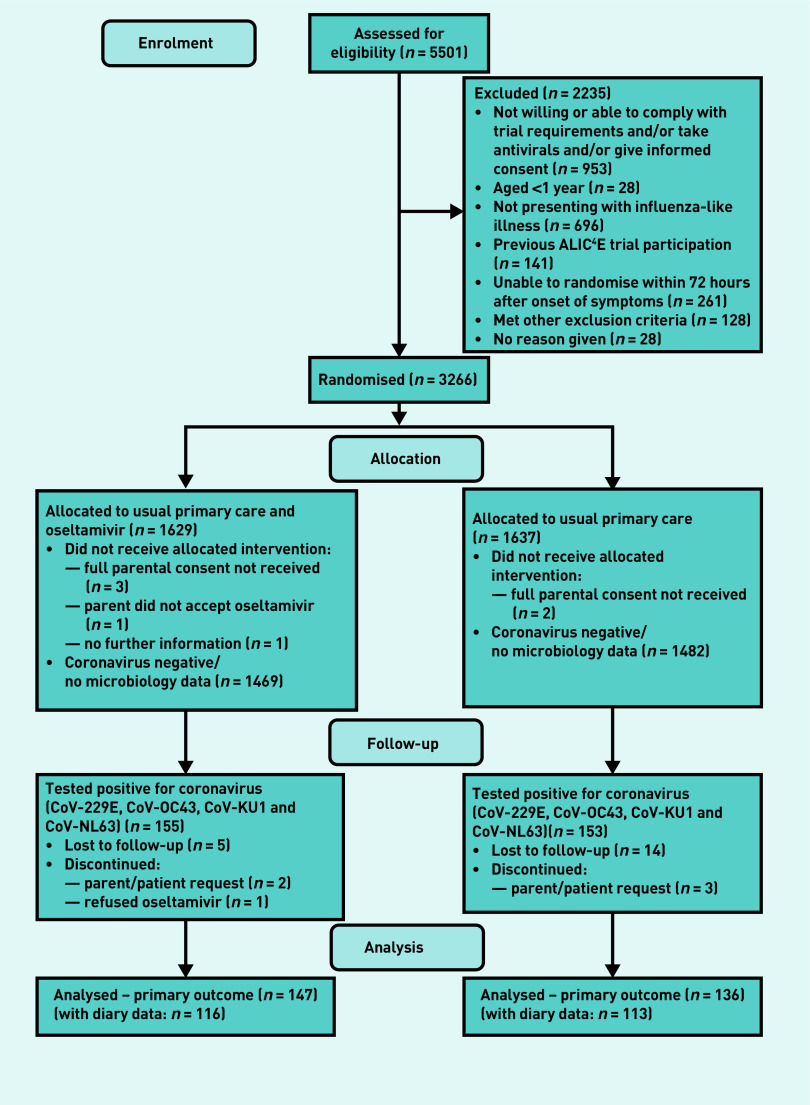
Flow of patients in the ALIC4E trial and of those who tested positive for coronavirus (not including SARS-CoV-2).